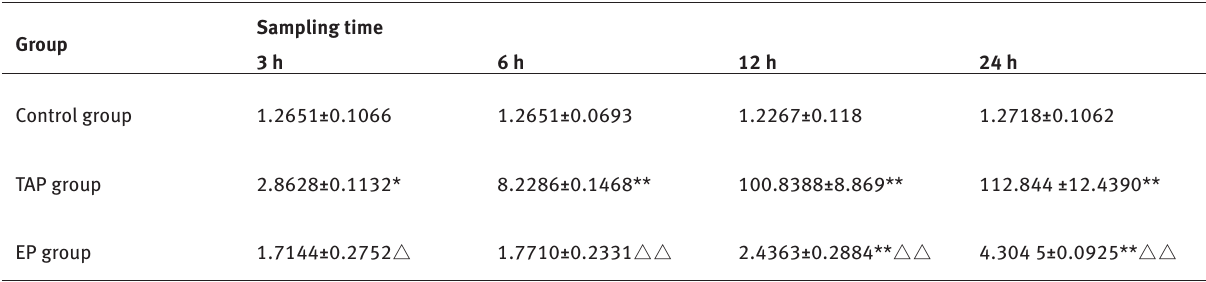
Table 1: Relative mRNA expression levels of HMGB1 in pancreatic acinar cells from the different rat groups at various time points ( per treatment group).